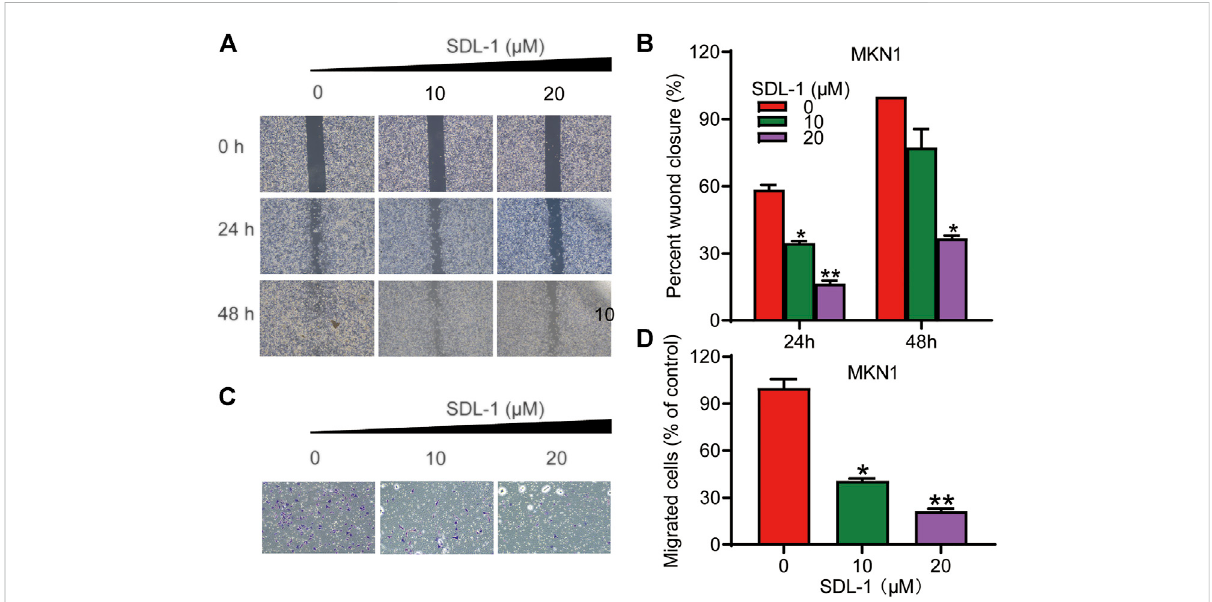
FIGURE 5 SDL-1 interfered with the invasion and metastasis of gastric cancer cell in vitro . (A,B) In the wound-healing assay, MKN1 cells were treated with SDL-1 at the speci fi ed concentration for 48 h, and the degree of cell healing was observed and recorded every 24 h (C,D) Transwell invasion assay was carried out in MKN1 cells treated with or without SDL-1. Results are presented as mean ± SD. (* p < 0.05; ** p < 0.01, *** p < 0.001).